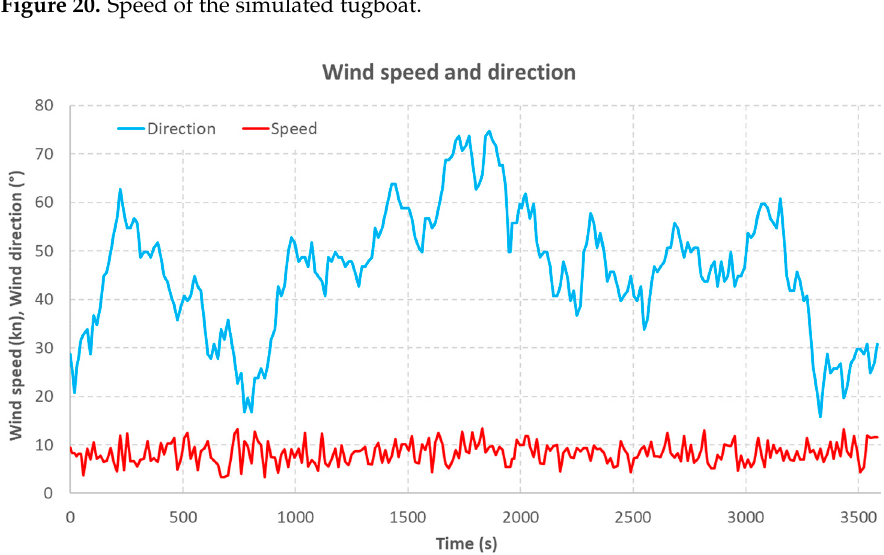
Figure 21. Wind speed and direction during the simulation.